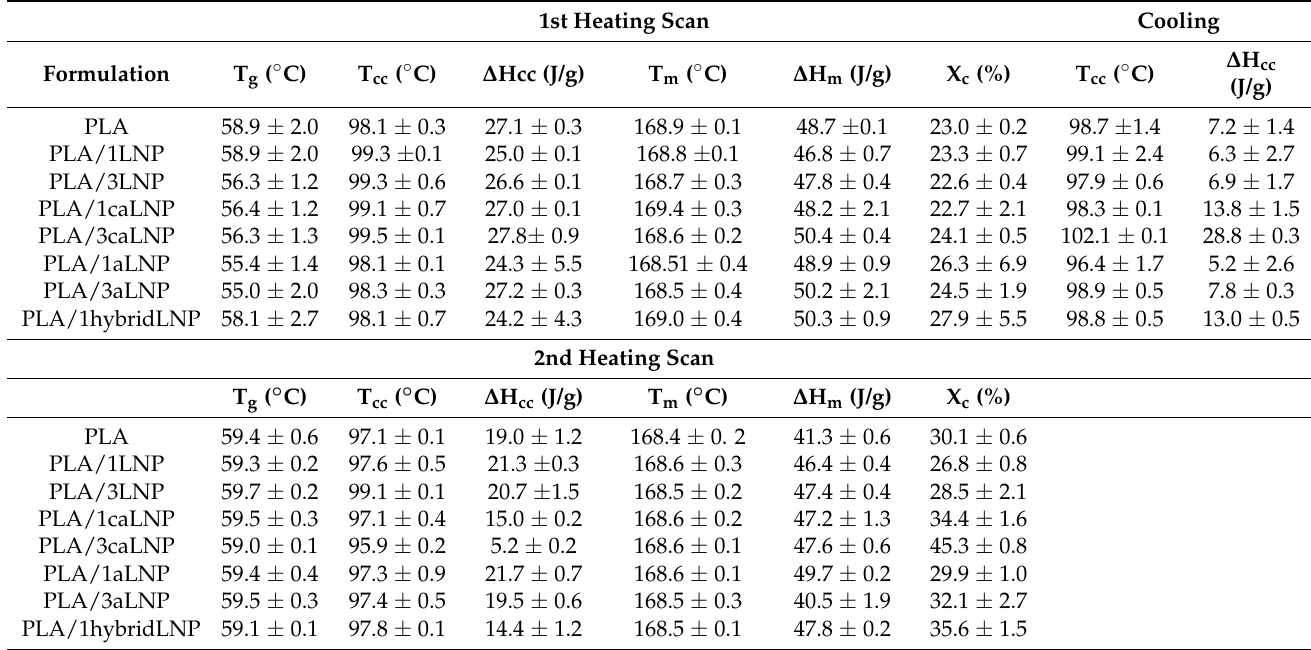
Table A1. Thermal parameters from DSC analysis of PLA and PLA nanocomposite